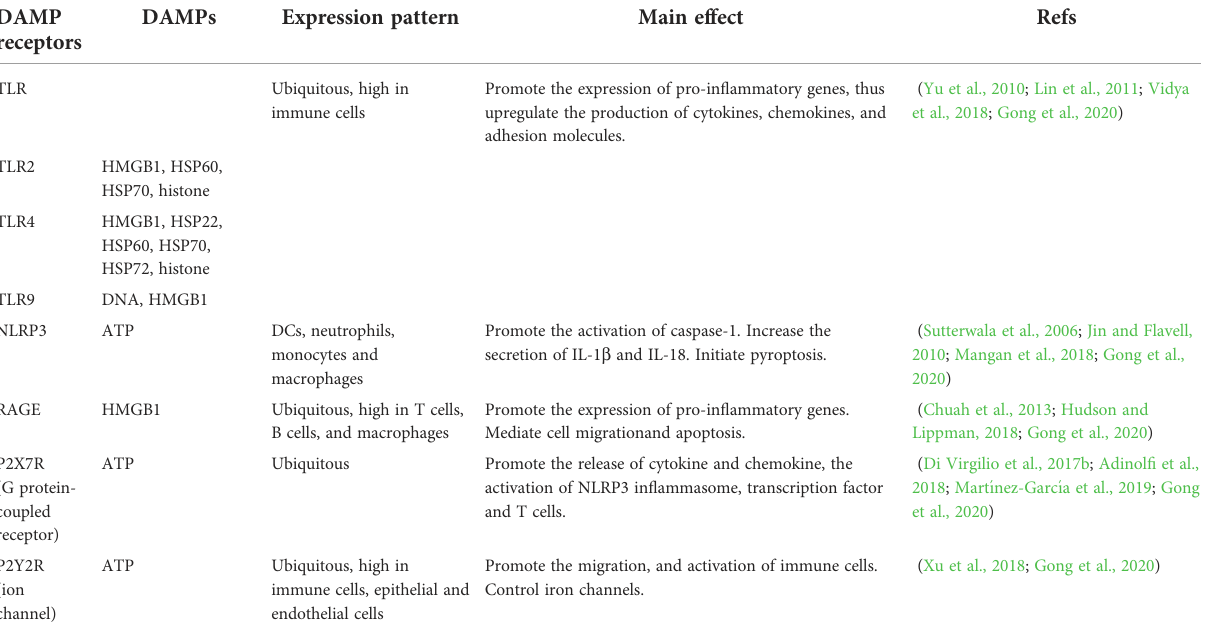
TABLE 1 DAMPs receptors, associated DAMPs, expression pattern and their effects related to AP. DAMP